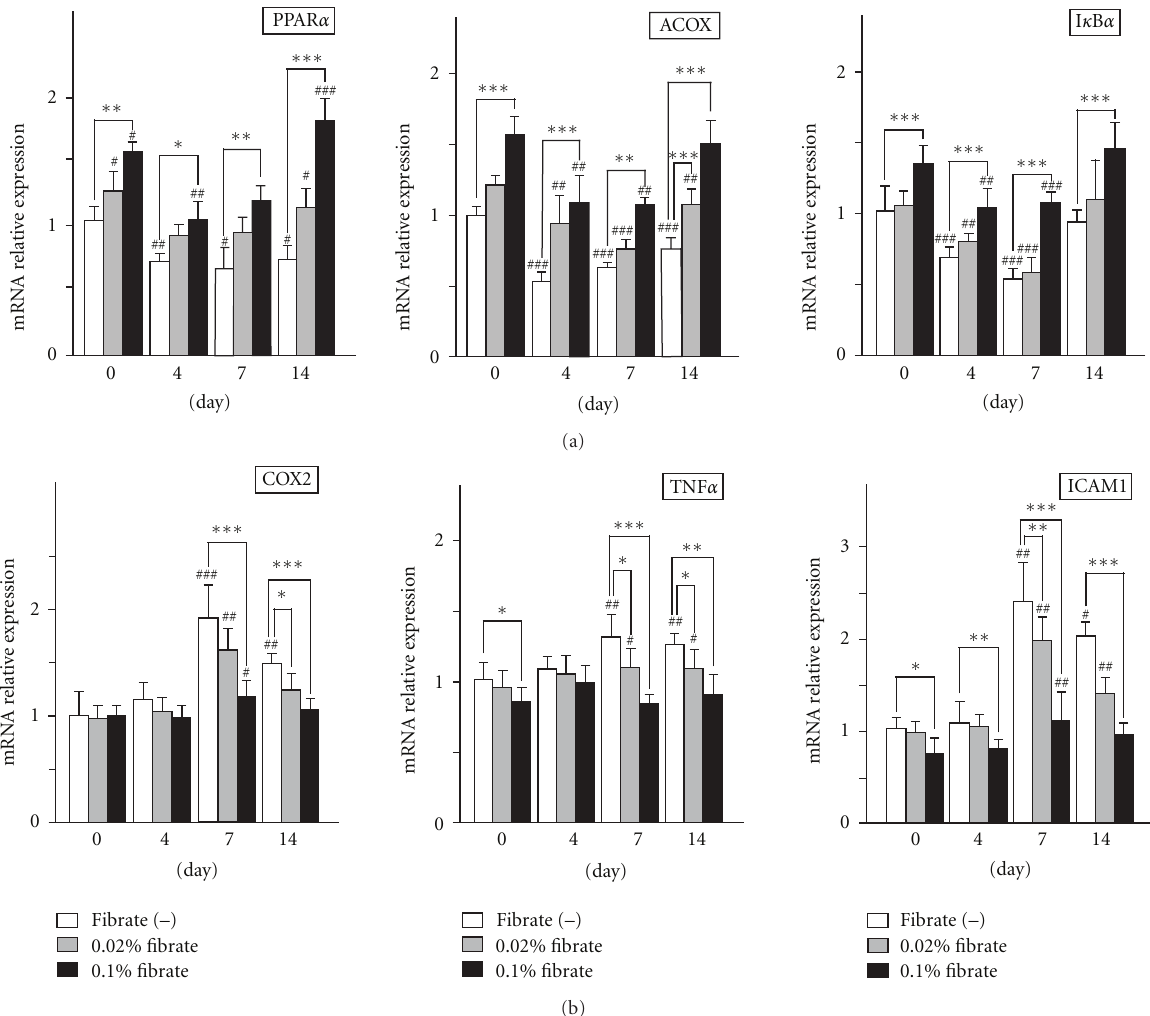
Figure 4: Alteration of mRNA expression of target molecules of transcription factors. mRNAs were obtained from glomeruli of each group of rats. The expression of mRNAs for the target molecules of PPAR α (a) and NF- κ B (b), including PPAR α , ACOX, I κ B α , COX2, TNF α , and ICAM1, was measured with real-time PCR. For relative quantification of mRNA, glyceraldehyde-3-phosphate dehydrogenase was used as an internal control, and the relative expression of RNA was calculated by the comparative threshold cycle (Ct) method. The expression was expressed as the change relative to that of the control rats (Fib( − ) group of rats at day 0). PCR reactions were carried out in triplicate and averaged for analysis. Values represent means ± SD. Significant di ff erences from the respective day 0 groups are indicated with number signs ( # P < 0 . 05, ## P < 0 . 01, ### P < 0 . 001), while significant di ff erences between regular-diet and clofibrate-diet groups are indicated with asterisks ( ∗ P < 0 . 05, ∗∗ P < 0 . 01, ∗∗∗ P < 0 .